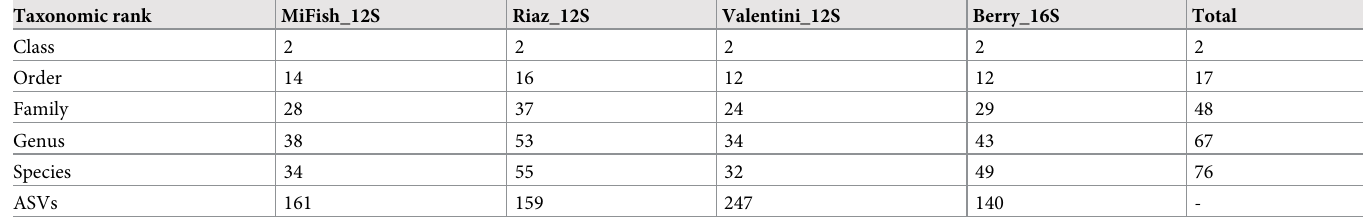
Table 3. Number of fish taxa detected for each of the four metabarcoding primer sets using the following similarity thresholds: 99% for species; 97% for genus; 95% for family; 90% for order; 85% for class; and 80% for phylum. Taxonomic rank